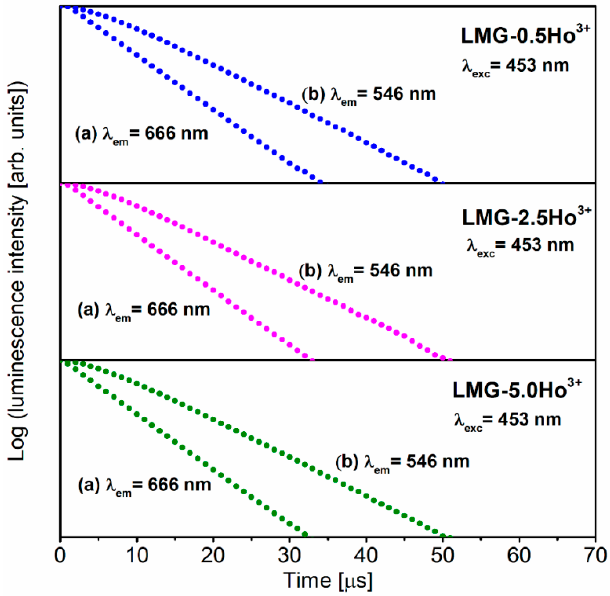
Figure 6. Decay curves for LMG-Ho 3+ ceramics with different contents of holmium ions.